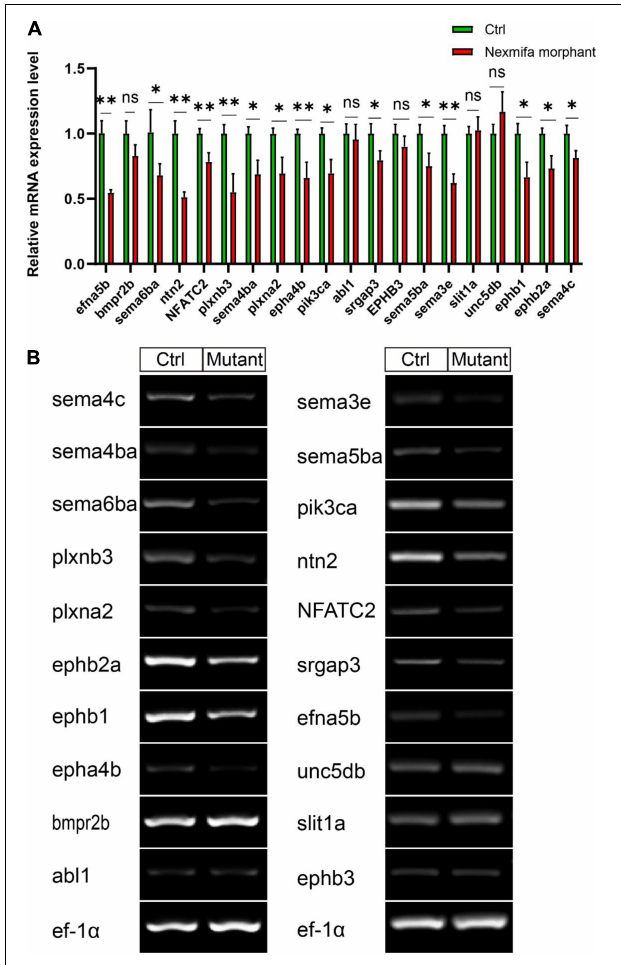
FIGURE 6 | The expression of 20 down-regulated DEGs. (A) Expression of 20 down-regulated DEGs between Ctrl and nexmifa morphant by qRT-PCR. Bars represent the mean ± standard deviation (SD). ∗ p < 0.05 and ∗∗ p < 0.01. ns: non-significant. (B) Expression of 20 down-regulated DEGs between Ctrl and nexmifa mutant by